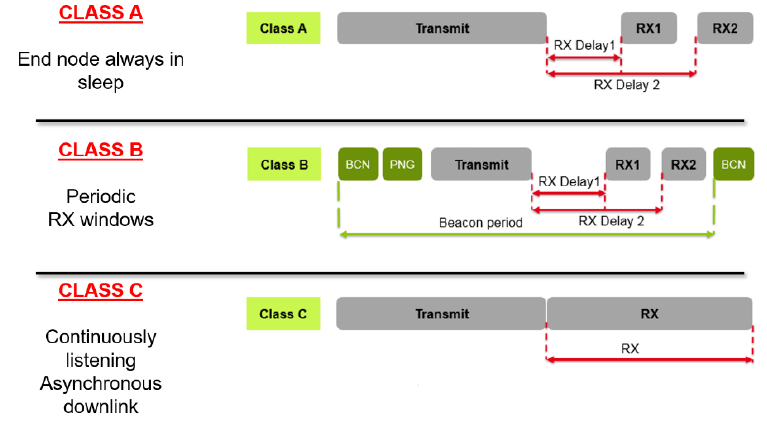
Figure 3. Uplink and Downlink methodology in Class A, B, and C.